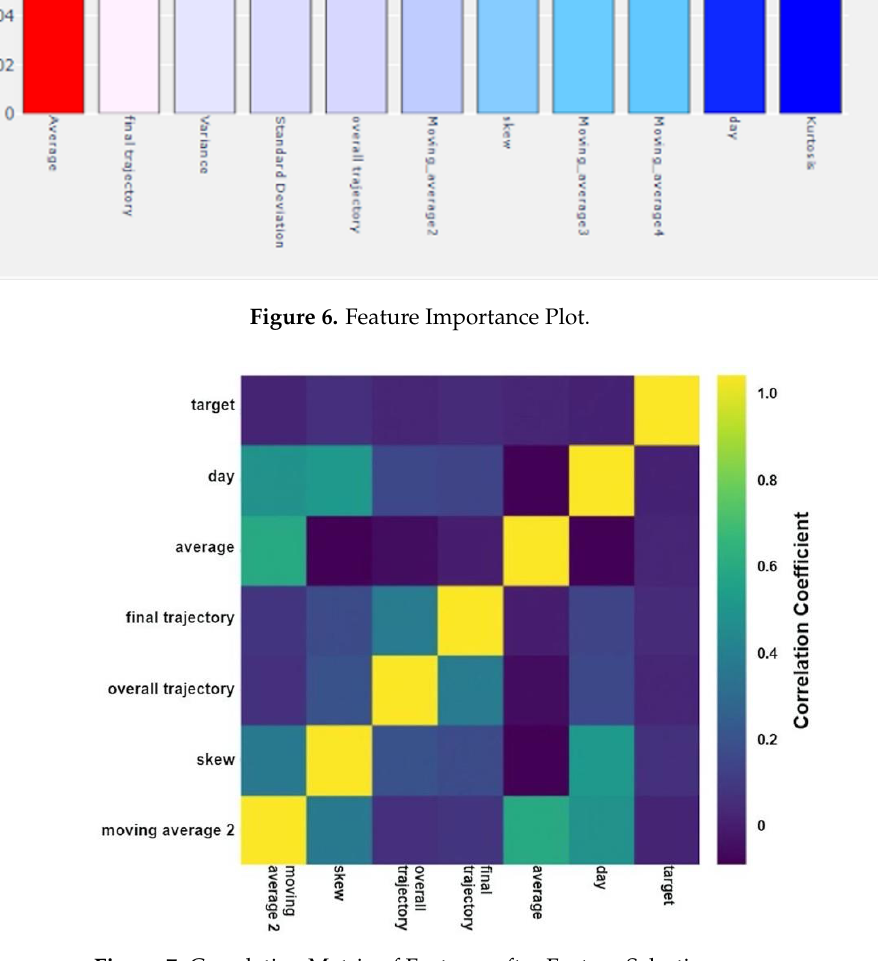
Figure 7. Correlation Matrix of Features after Feature Selection. Table 6. Target values after SMOTE.